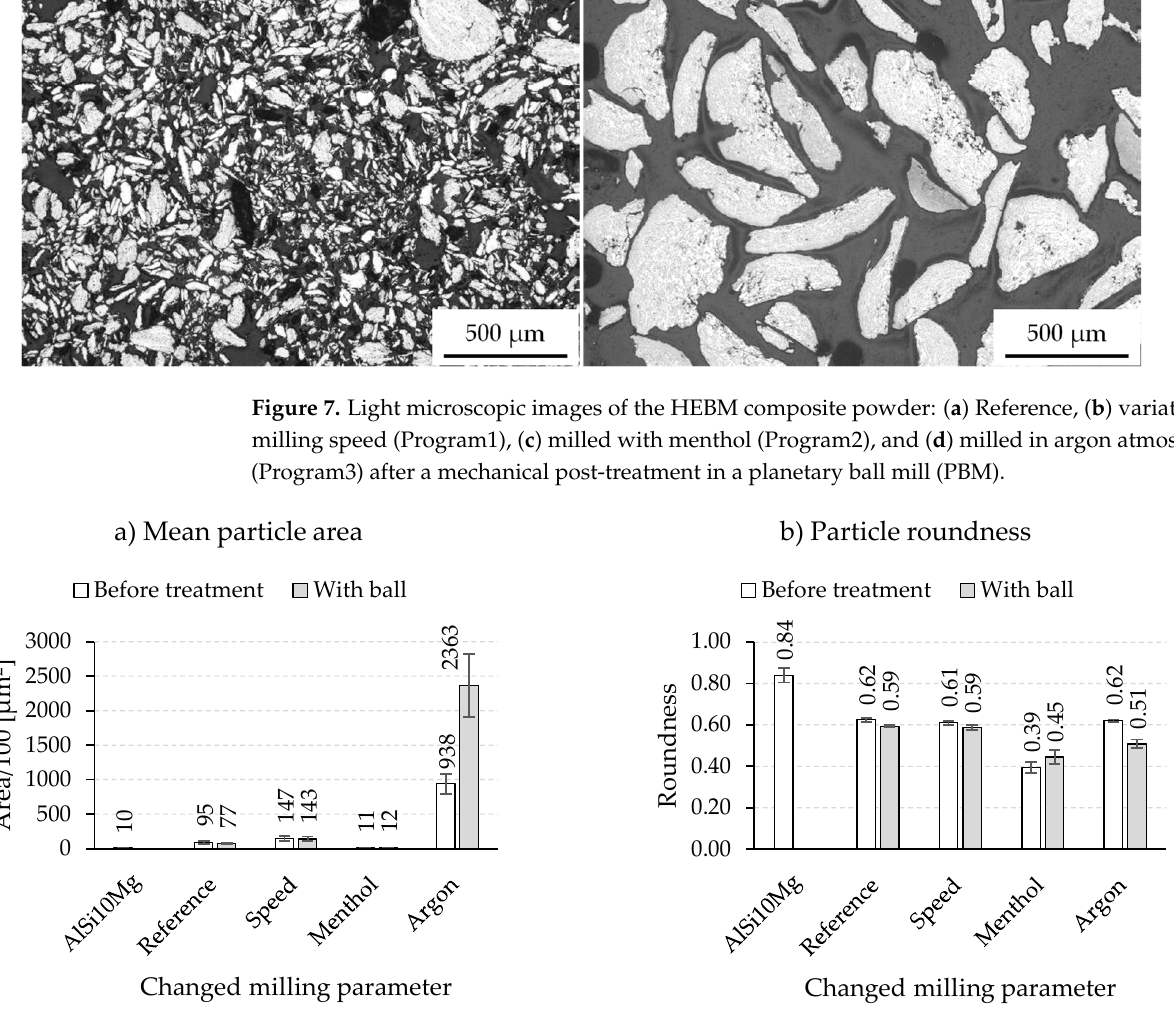
Figure 8. Results of ( a ) mean particle area and ( b ) roundness after a mechanical post-treatment in planetary ball mill.